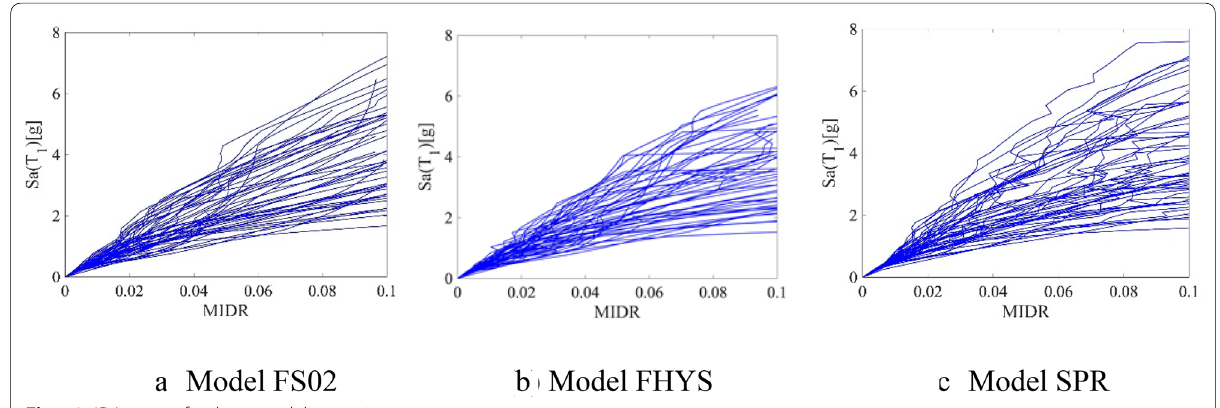
Fig. 10 IDA curves for three modeling